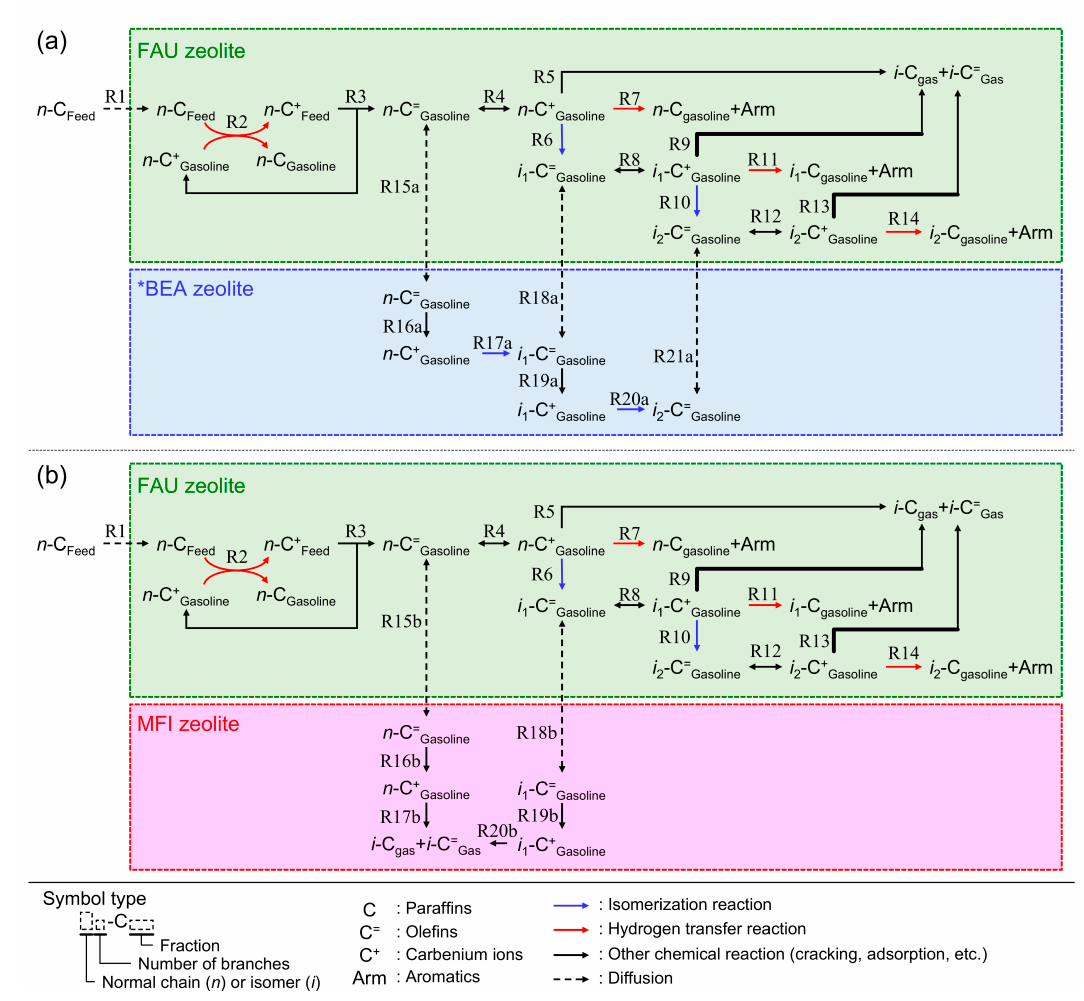
Figure 7. Reaction scheme of the n -hexadecane cracking on the composite catalyst. ( a ) Composite with *BEA zeolite. ( b ) Composite with MFI